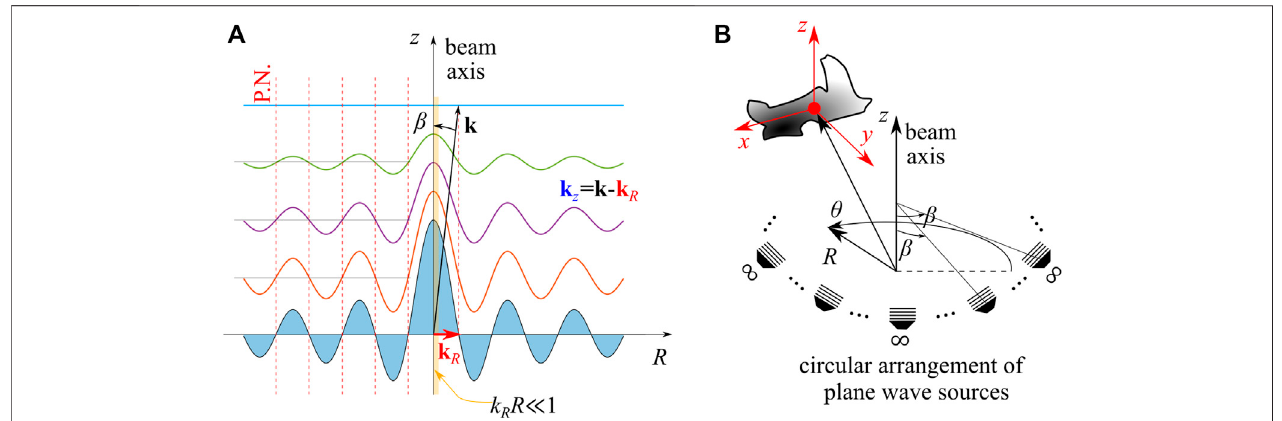
FIGURE 1 | Acoustic Bessel beam of zeroth order in cylindrical coordinate system with beam axis aligned with the z -axis, (A) the wave front variation over a half wavelength in the z -direction, showing a travelling wave propagation, (B) the circular arrangement of sources at in fi nite distance emitting plane waves at angle β with respecttothe z -axistogenerateaBesselbeamofzerothorder[11].Thecylindricalcoordinates( R , θ , z )ofthepositionvectorofanobjectwitharbitraryshapelocatedoff- axis and the local Cartesian coordinate system are shown. The wave vector k and its components k R and k z and their relation with the cone angle β are shown in panel (A) . The dotted lines in panel (A) shows the pressure nodes (P.N.) of the Bessel beam, implying a standing wave behaviour in the radial R